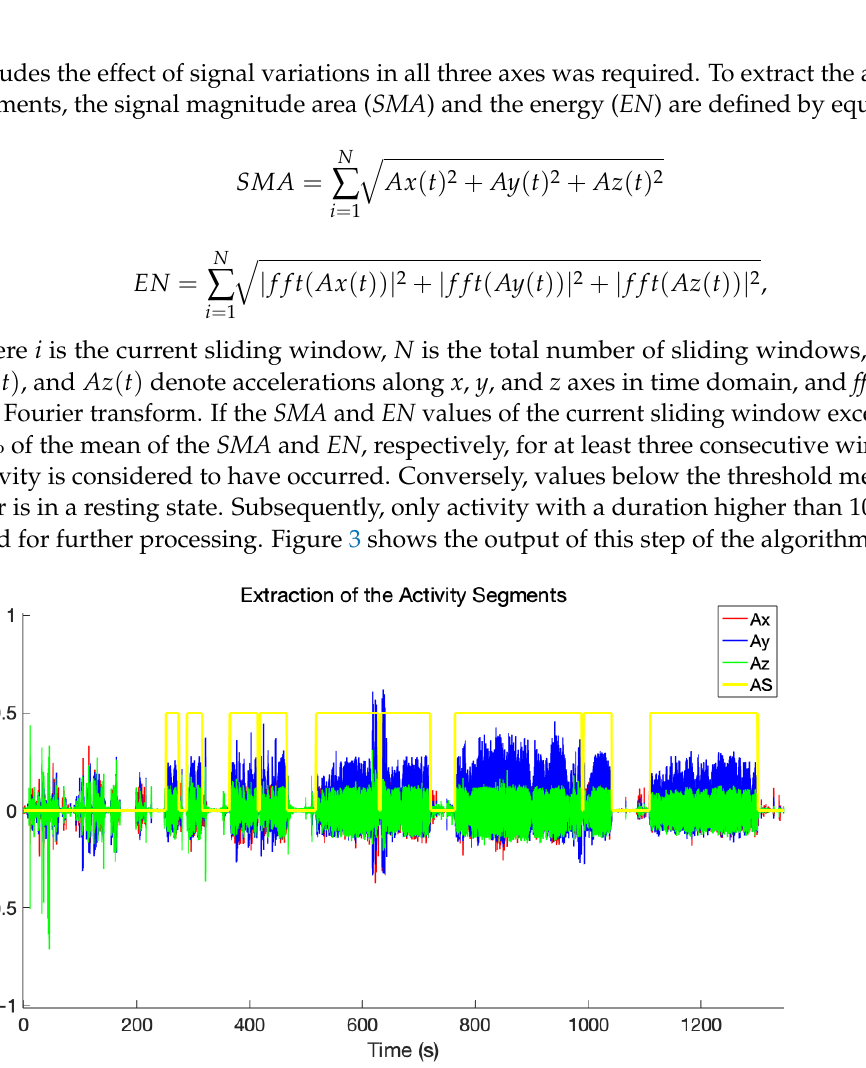
Figure 3. The superposition of the x –axis (red), y –axis (blue), and z –axis (green) components of acceleration and the extracted activity segments (yellow) as a function of